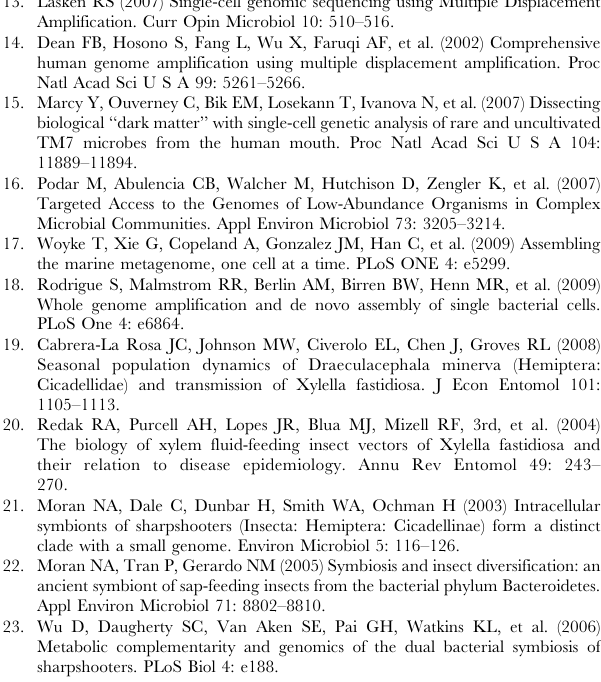
Found at: doi:10.1371/journal.pone.0010314.s003 (0.65 MB TIF) Figure S4 Estimated SNP recovery rates at given sequence depths, based on simulated Escherichia coli datasets. Reads from two strains of E. coli were combined, generating a series of data sets that varied in both depth and ratio of contribution from each strain. To simulate allele frequency of .25 and read depth 40 6 , reads totaling 30 6 of average read depth for strain A and 10 6 for strain B were randomly selected and aligned to strain A’s reference. The percentage of the known 170 variants between the two strains that were correctly identified using consed are reported. Using the above simulations and the metagenome coverage ( . 67% of their genomes covered at a minimum depth of 20 6 ), we estimate that we have found , 60% (67% cover- age 6 90% SNP discovery rate) of all SNPs at allele frequency 0.5 and 40% (67% coverage 6 60% SNP discovery rate) of all SNPs at allele frequency of .25. Table S1 Primers and probes used for DMIN Sulcia single cell